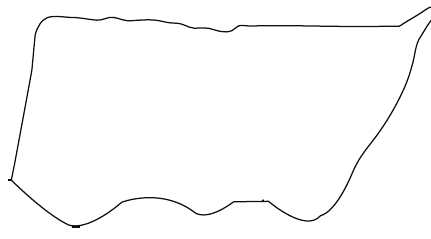
Figure 3: Image Binarization and